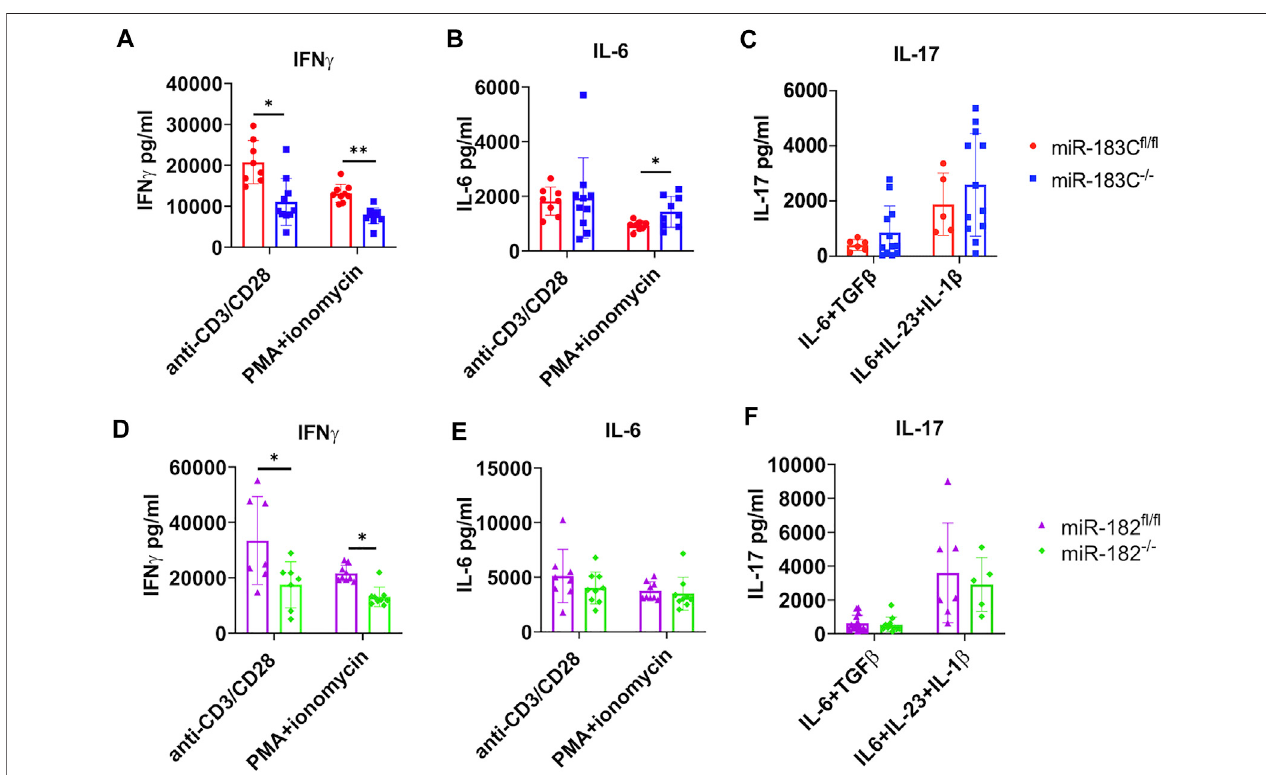
FIGURE6| ExamtheeffectofmiR-182andmiR-183CdeletiononIFN γ ,IL-6,andIL-17productionin invitro activatedsplenocyteswithdifferentstimuli.Thefreshly isolated splenocytes from miR-183C − /- B6/lpr (A – C) , miR-182 − / − B6/lpr (D – F) and their respective littermate control miR-miR-183C fl / fl and miR-182 fl / fl B6/lpr mice were stimulatedwithanti-CD3 plus anti-CD28 for24 h, PMAplus ionomycin for6h,non-pathogenic Th17stimuli orpathogenic Th17stimulifor72 h. Theproduction speci fi c cytokines in culture supernatant were measured by ELISA. (A – C) Summary graphs show deletion ofmiR183C in vivo in B6/lpr mice suppressed IFN γ , but not IL-6 andIL-17insplenocytesfollowing invitro stimulationwithspeci fi cstimuli. (D – F) SummarygraphsshowdeletionofmiR182alone invivo inB6/lprmicesuppressedIFN γ , butnotIL-6andIL-17in invitro activatedsplenocyteswithspeci fi cstimuli.Thegraphswereshownasmeans±SD( n ≥ 5).Unpairedstudentttestswereperformed(miR- 183C fl / fl vs . miR-183C − / − , miR-182 fl / fl vs . miR-182 − / − ) for statistical analysis; *, p < 0.05; **, p < 0.01; and ***, p <